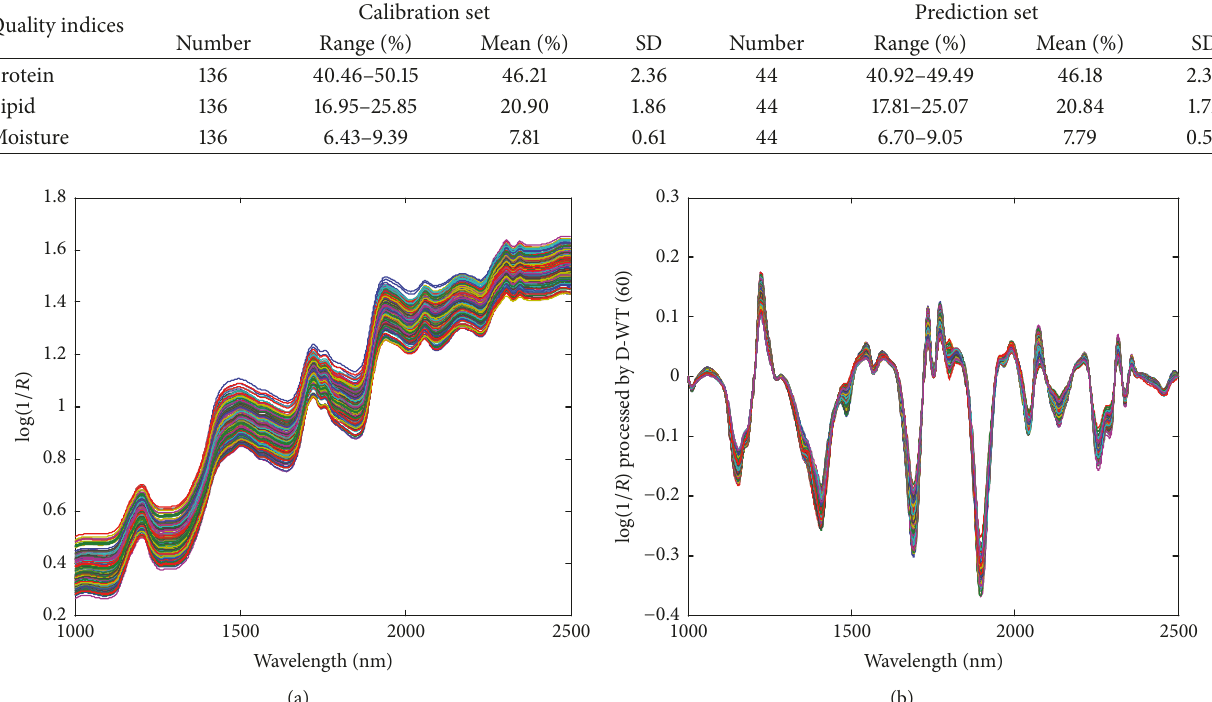
Figure 2: log (1/𝑅) spectra from (a) original data and (b) processed data by the D-WT